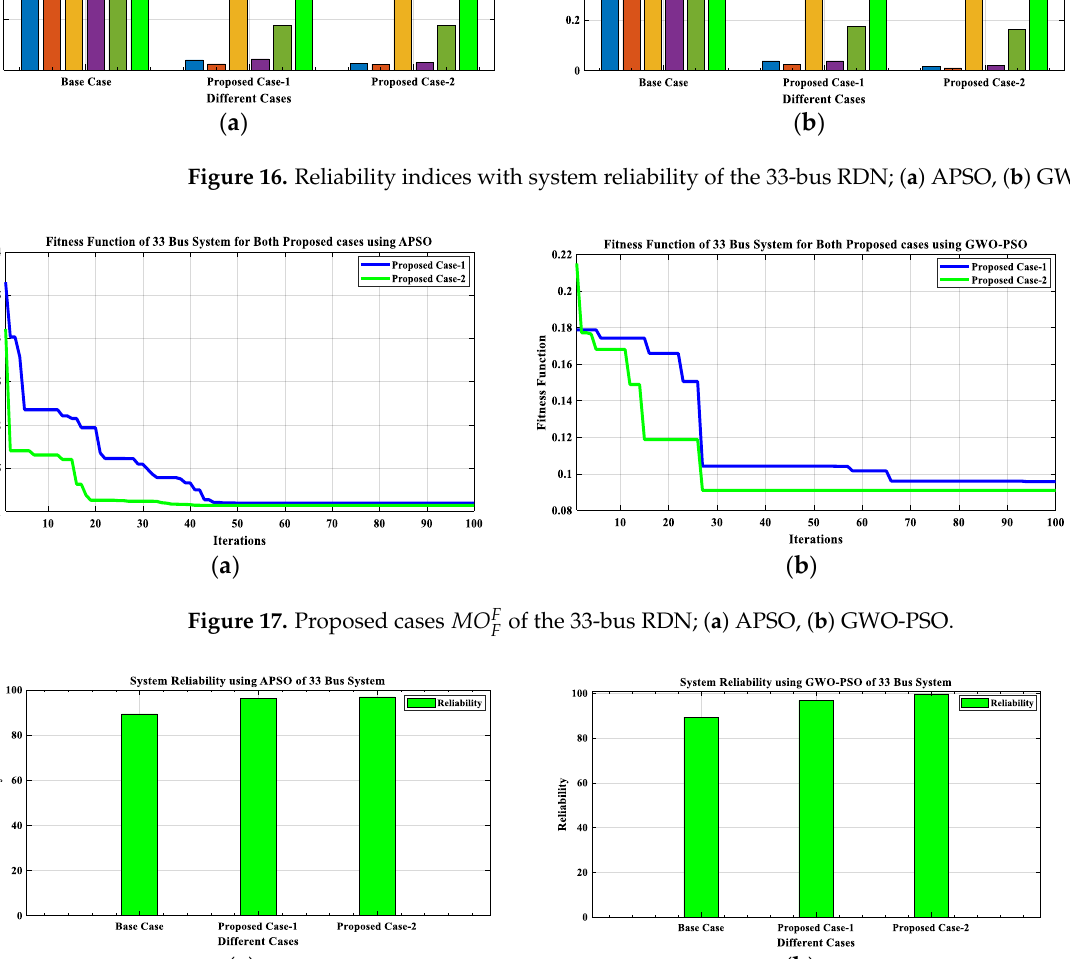
Figure 18. All proposed cases ’ percentage reliability of the 33-bus RDN; ( a ) APSO, ( b ) GWO-PSO.